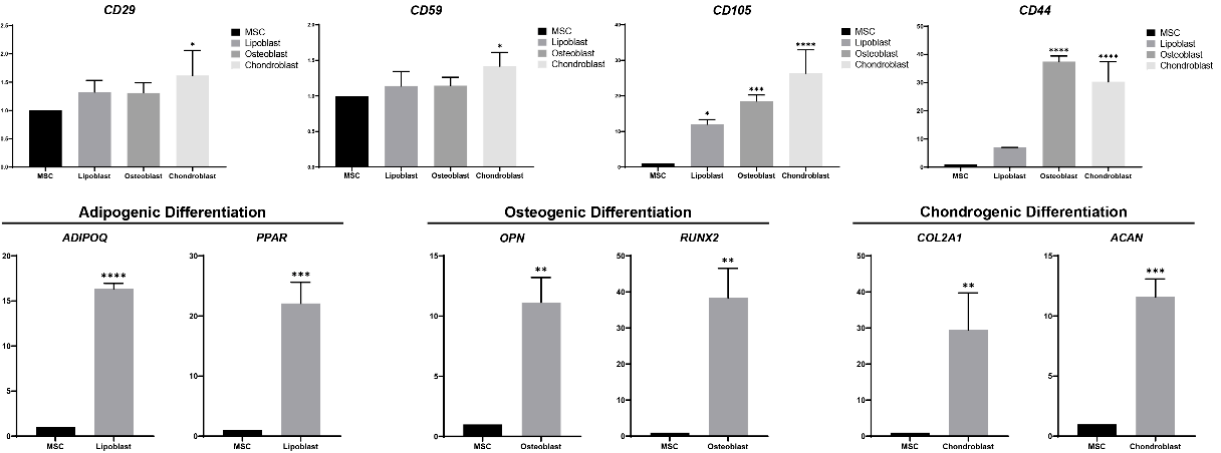
Figure 5. Gene expression of MSCs by differentiating into lipoblasts, osteoblasts, and chondroblasts. Marker gene expression ( CD29 , CD59 , CD105 , and CD44 ) of MSCs after differentiation; marker gene expression of adipocytes ( ADIPOQ and PPAR ), osteoblasts ( OPN and RUNX2 ) and chondroblasts ( COL2A1 and ACAN ) after the differentiation of MSCs. * p < 0.05, ** p < 0.01, *** p < 0.001, **** p < 0.0001.